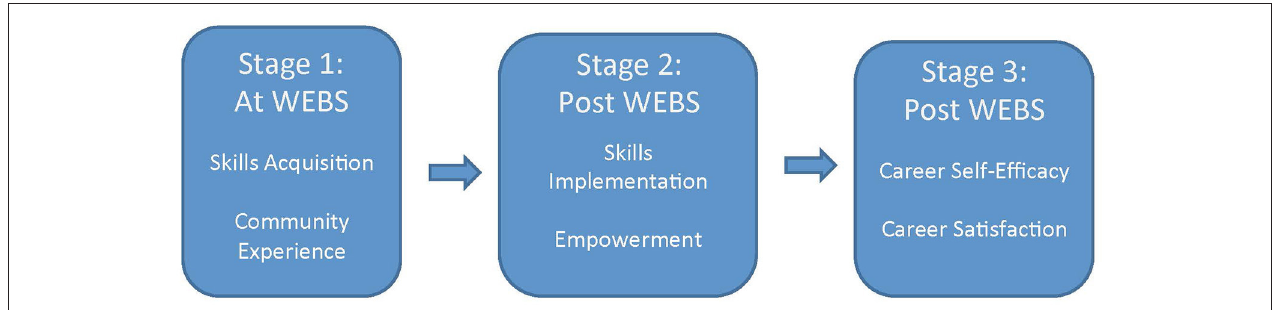
FIGURE 1 | WEBS Program Framework. The program framework describes the conceptual approach of the WEBS experience. Survey respondents reported that their participation WEBS was a transformative experience that resulted in improved career-self efficacy, empowerment and satisfaction for early career women in